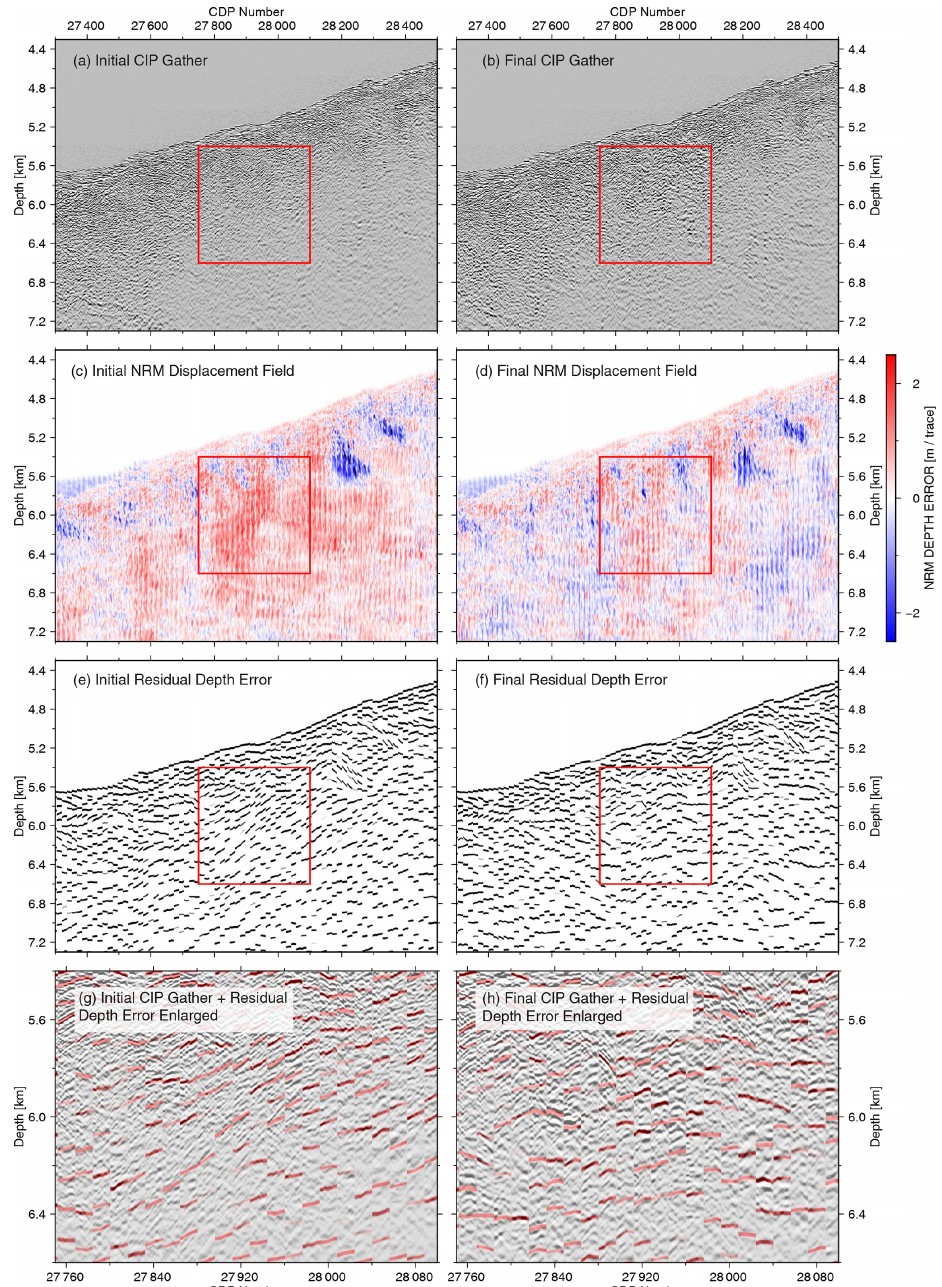
Figure 13. NRM velocity updating of Fig. 12 in CIP domain. (a) CIP gathers based on the initial velocity model. (b) CIP gathers based on the final velocity model. (c) Initial NRM depth shifts in the CIP domain. (d) Final NRM depth shift in CIP domain. (e) RMO picks calculated from the initial NRM displacement field. (f) RMO picks calculated from the final NRM displacement field. Note that the distinct area of velocity underestimation in the red rectangle in (c) has been substantially decreased after the tomography (d) . CIP gathers (e) and (f) of the red rectangle from (c) and (d) respectively overlaid by RMO picks. Strong dipping events in the initial CIP gather (g) have only partially flattened after the final iteration (h)